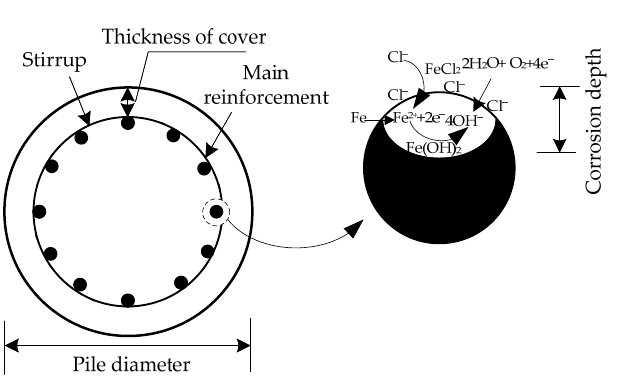
Figure 3. Diagram of a cross ‐ section of reinforced concrete pile and reinforcement corrosion mech ‐ anism.